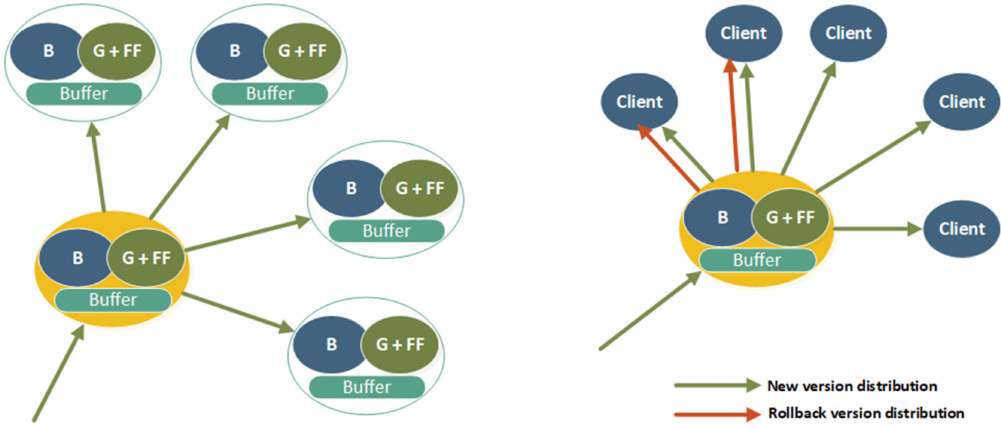
Figure 9. Client update distribution with sentinel node ( left ) and backup node ( right